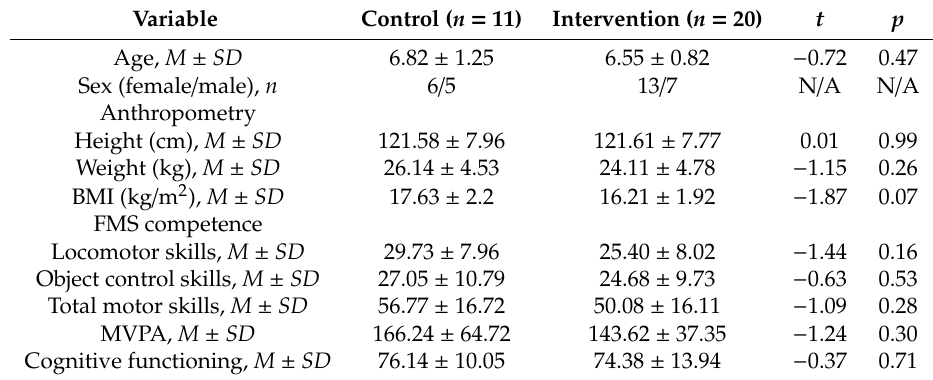
Table 1. Descriptive characteristics between the groups from the